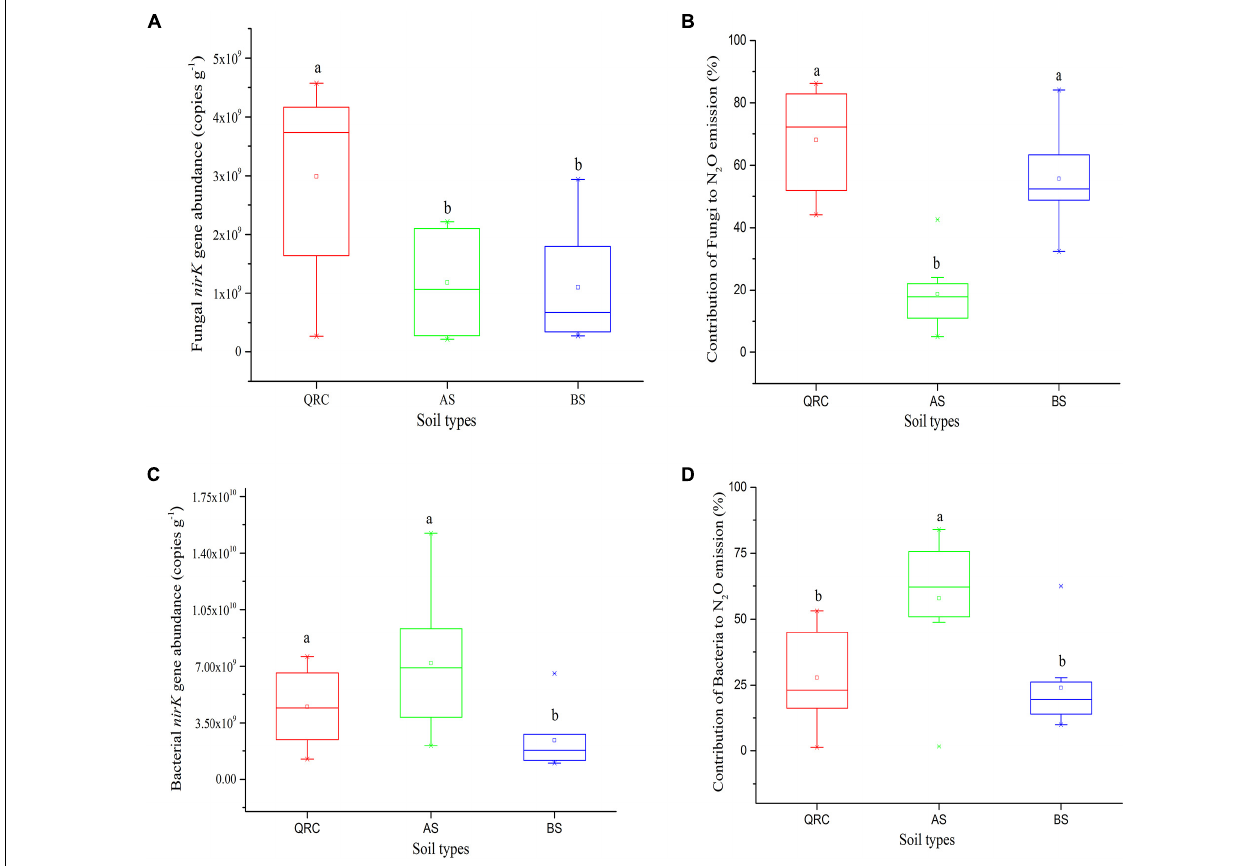
FIGURE 3 | nirK abundance of fungal (A) and bacterial (C) , N 2 O emission from fungal (B) and bacterial (D) denitrification in three soil types. Different letters (a, b) represent significant differences among three soil types at P < 0.05 ( n = 10). AS, alluvial soils; BS, black soils; QRC, quaternary red clay